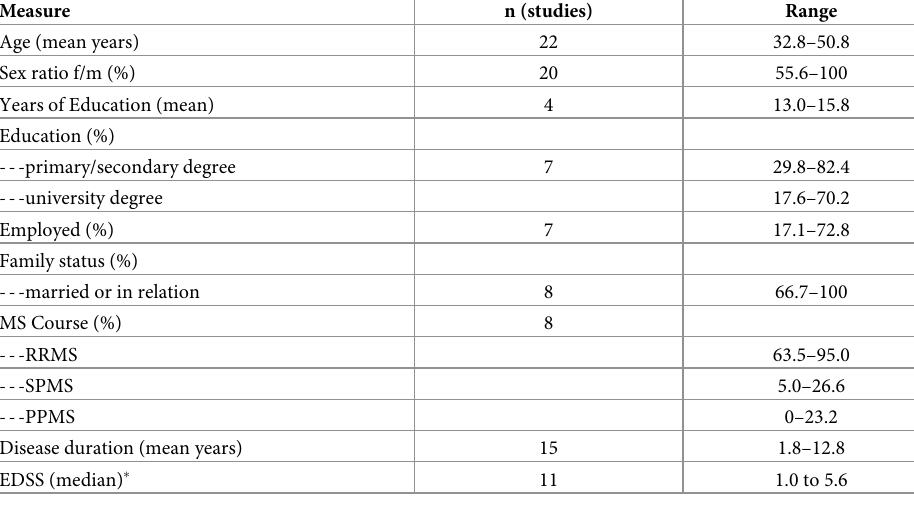
Table 1. Demographic and disease specific data of people with MS (n = 23